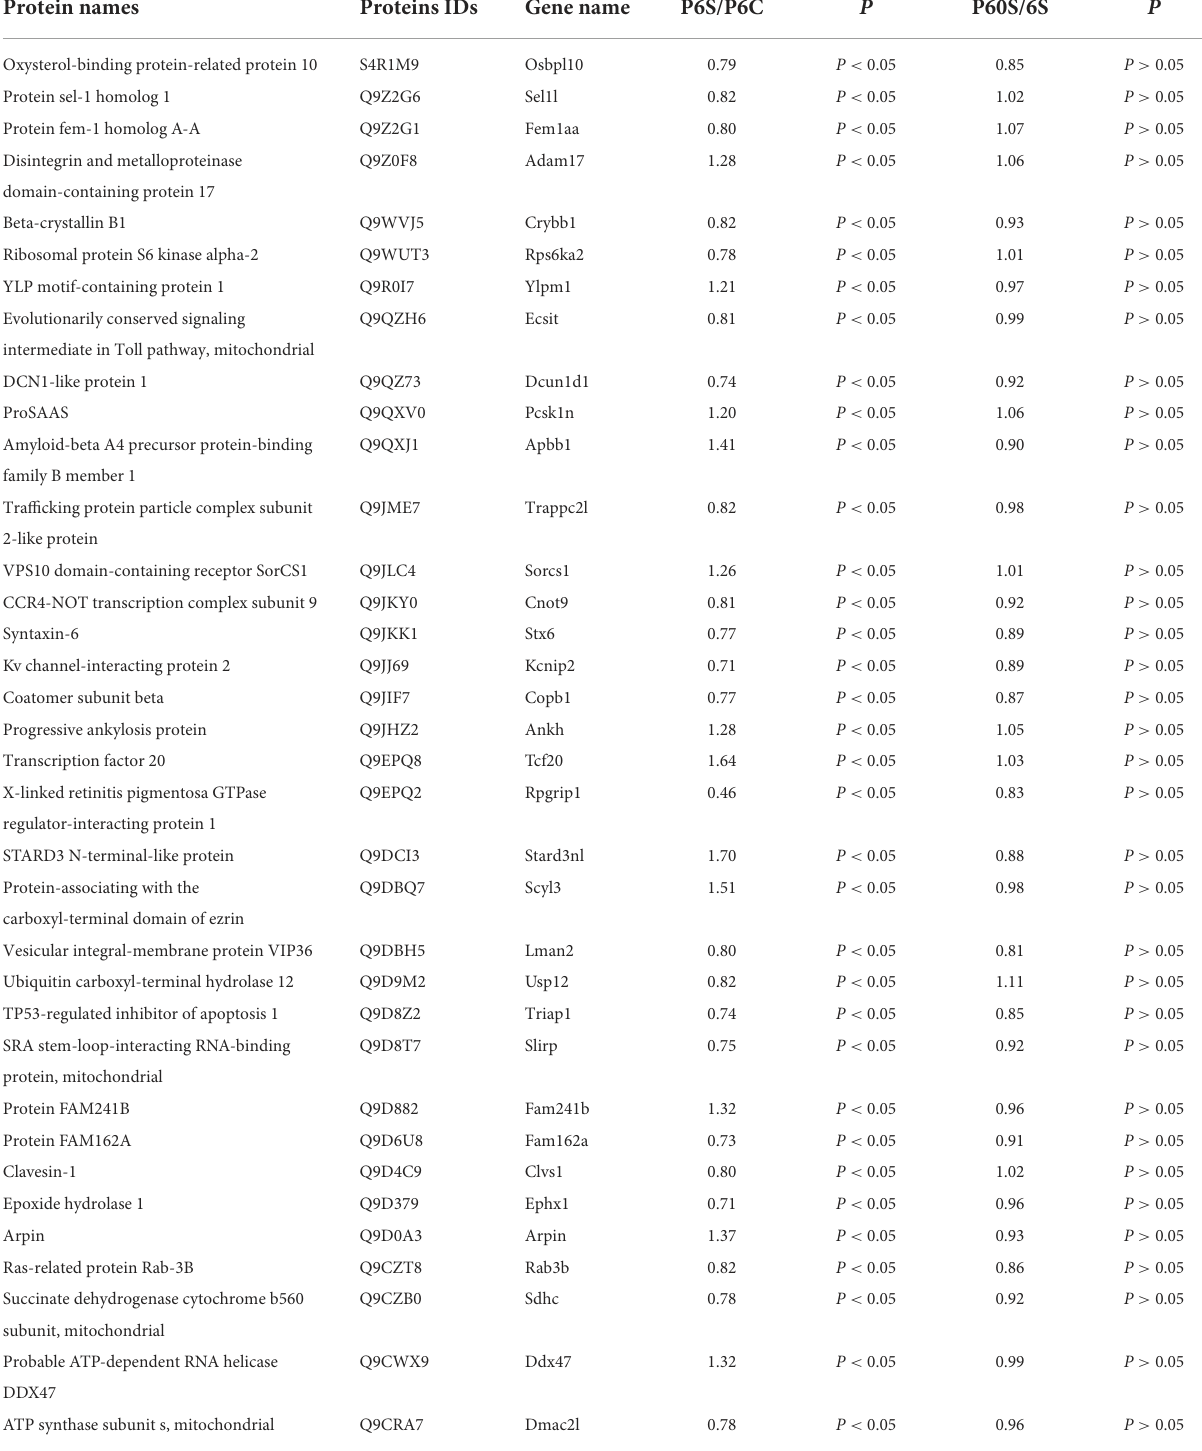
TABLE 2 List of the several sevoflurane-related significantly differential proteins in condition